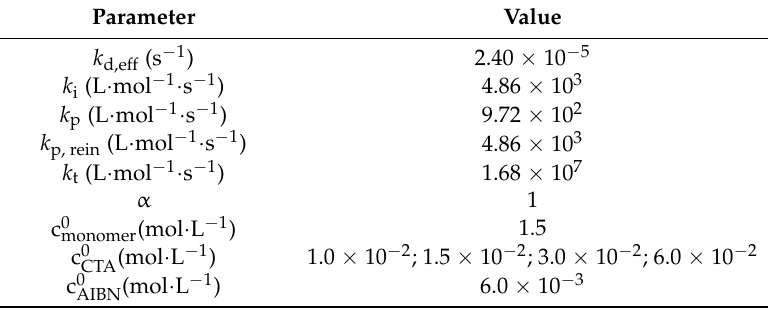
Table 4. Set of fixed input parameters for the PREDICI ® simulations of CPDB-mediated polymerization of TBDMSMA in toluene at 70 ◦ C.